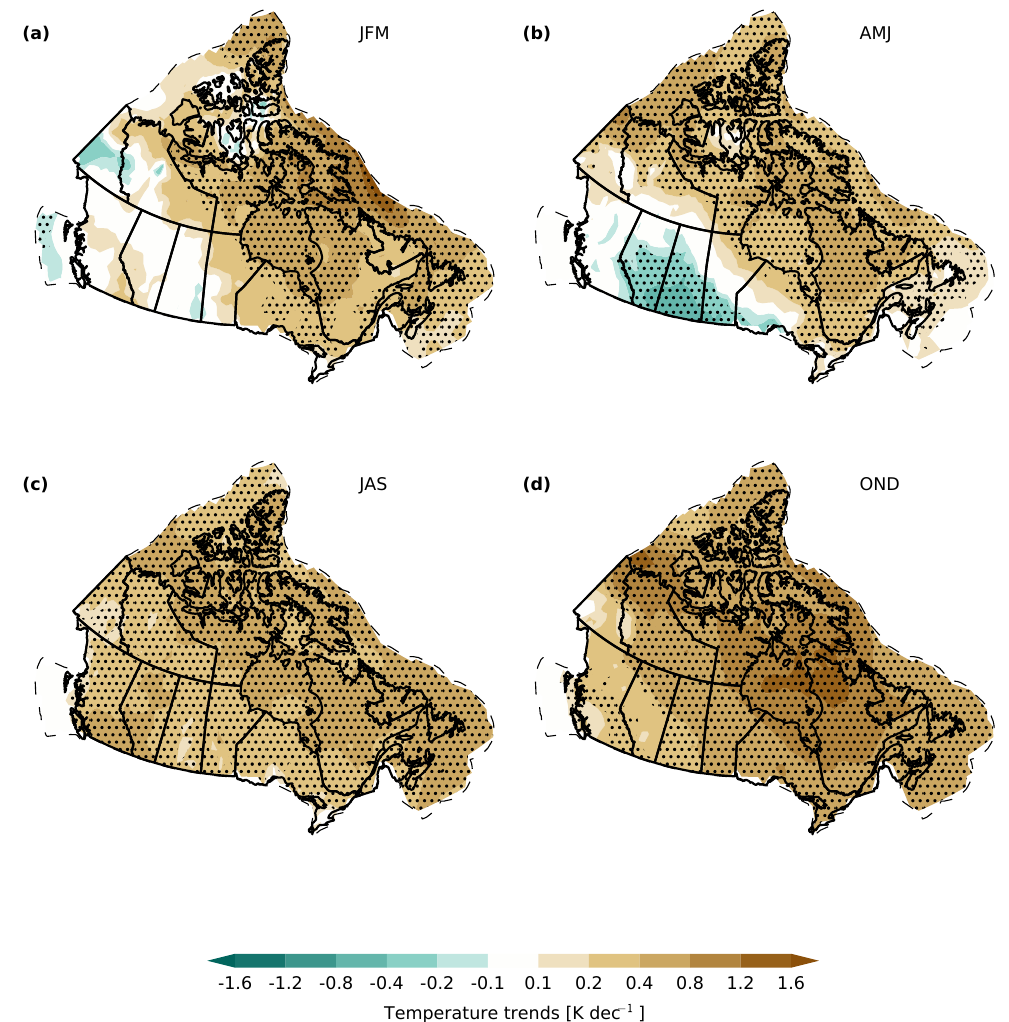
Figure 2. Trends in surface temperature, 1981–2015, from a blend of ERA-Interim, JRA-55, JRA-25, MERRA-1, MERRA-2, and CFSR reanalysis products. Stippling indicates pointwise significance at the 90th